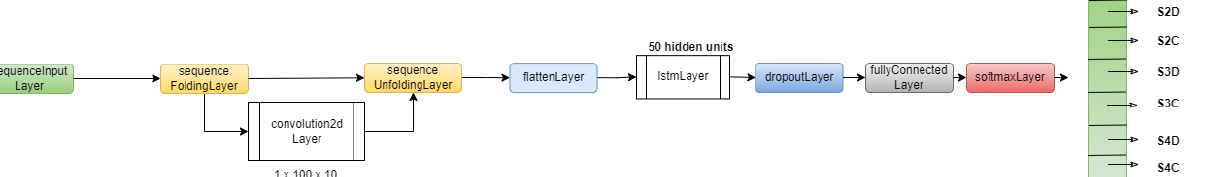
Figure 7. CNN-LSTM